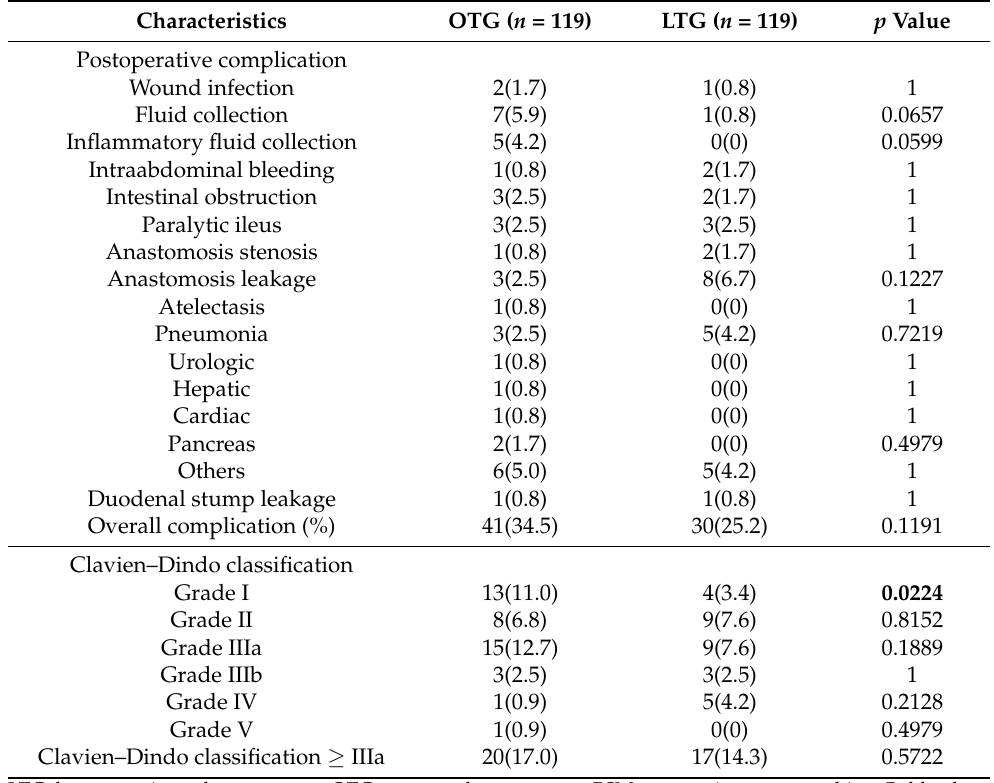
Table 3. Postoperative surgical complications after